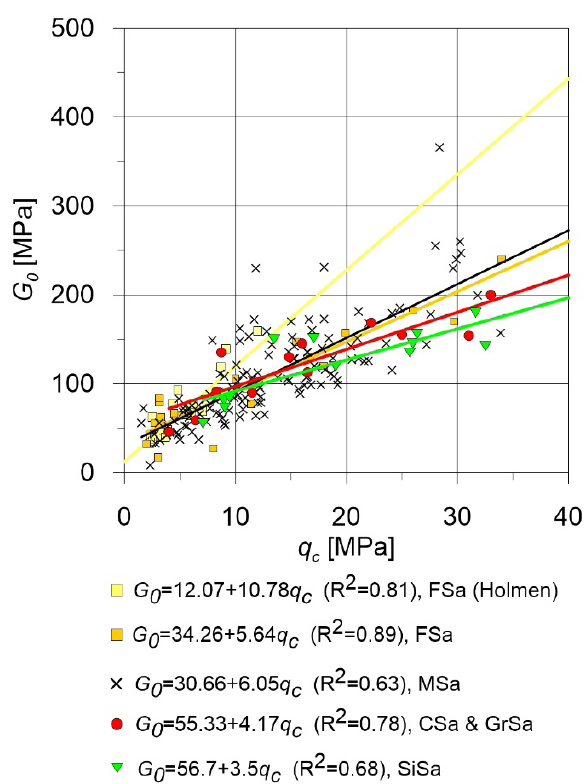
and cone resistance q 0 c